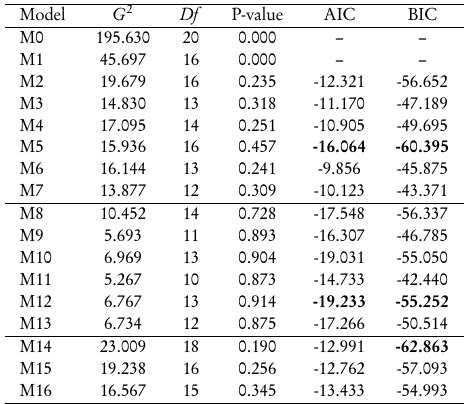
The results of goodness-of-fit test and the parameter estimates for the